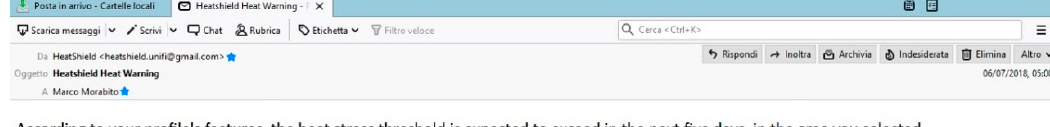
Figure 6. The HEAT-SHIELD warning sent to the user ’ s e-mail when at least one day with a moderate (or high) heat stress risk level is expected in the short term (the first 5-day forecasts of the HEAT- SHIELD platform).